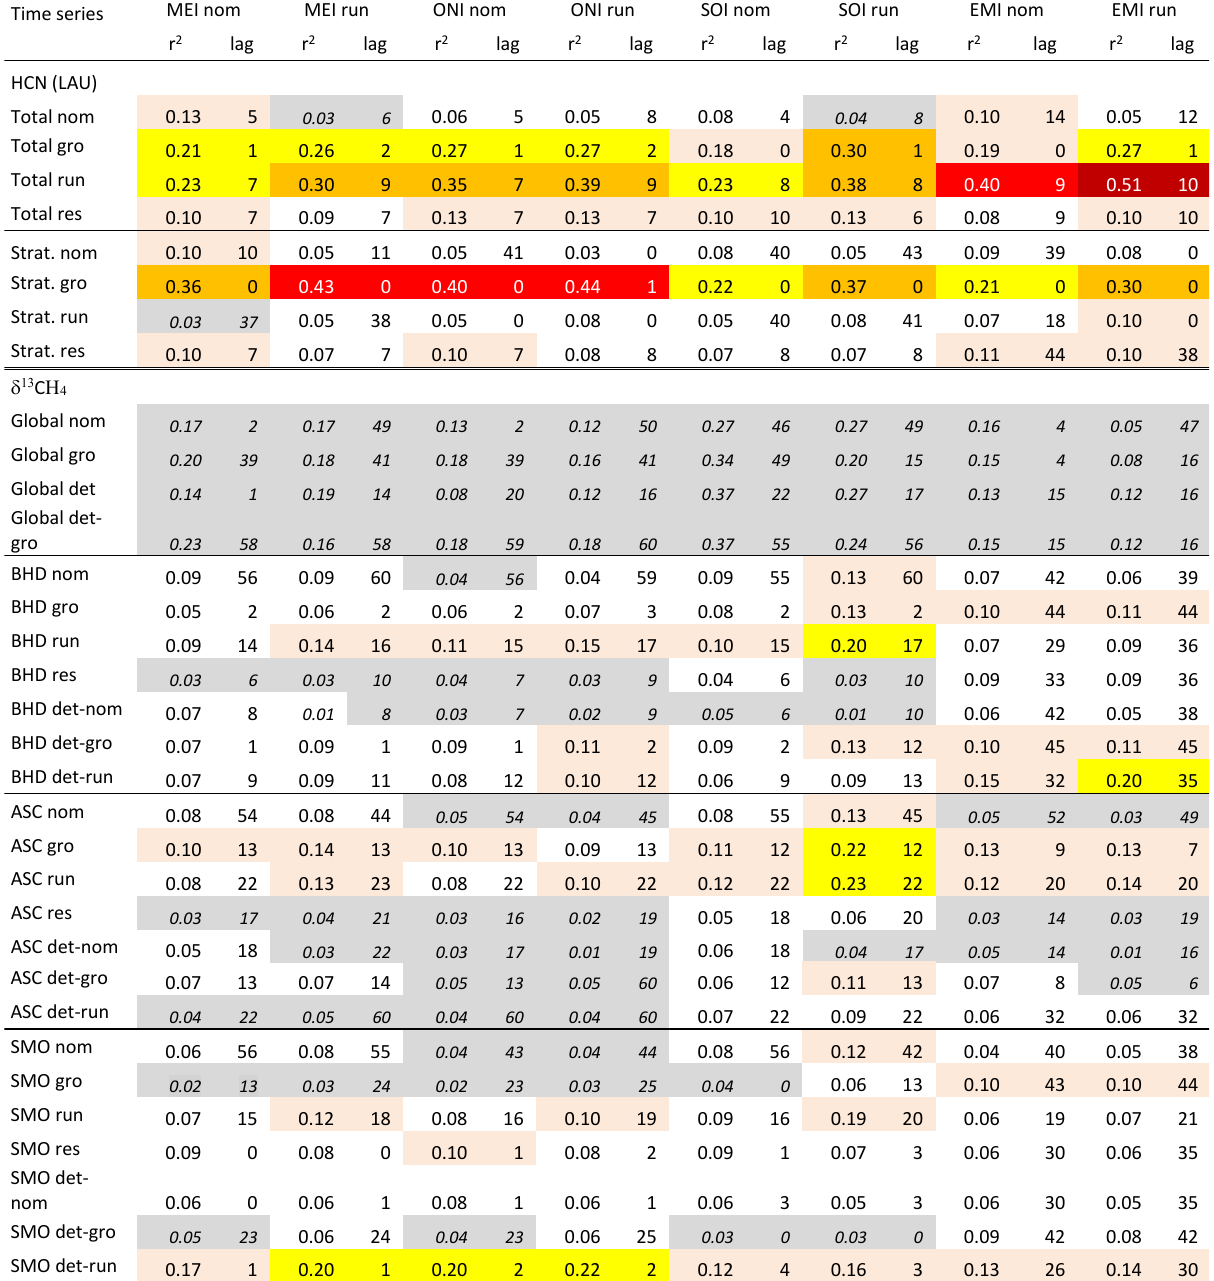
Table 3. Spearman correlation of δ 13 CH 4 and HCN with ENSO variability. Correlations ( r 2 values) for the Spearman ranking coefficient between dependent variables, i.e. δ 13 CH 4 and HCN time series from various sites, and ENSO indices with lag times (in months) for optimum results. Colour backgrounds indicate r 2 values in 10% classes. Grey background indicates correlations with p values>0.001.